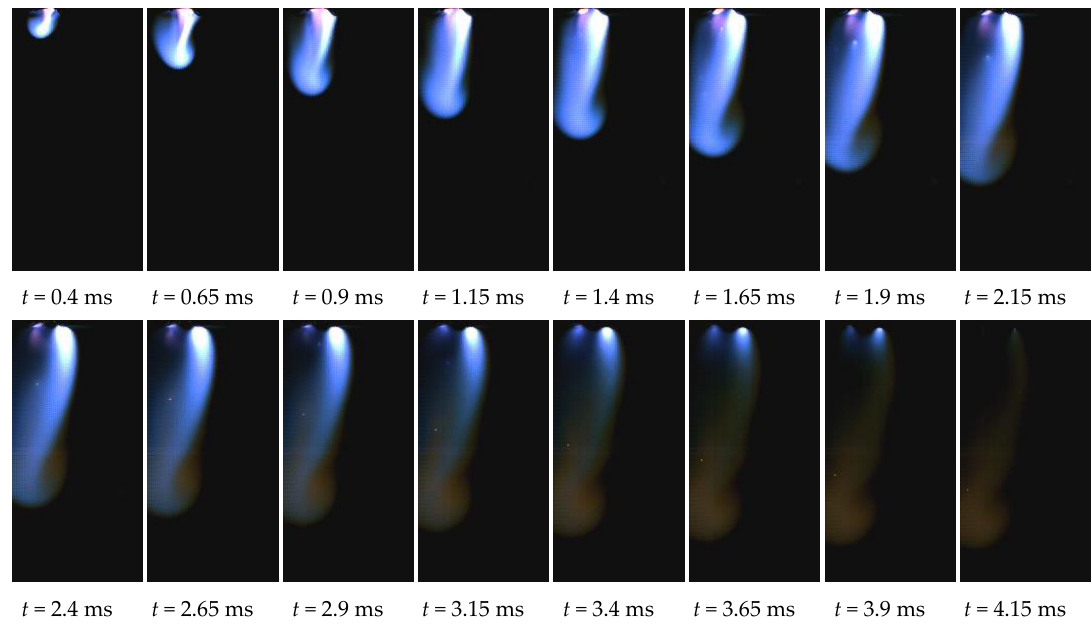
(b) Figure 4. Numerical results of ( a ) Li [54] and ( b ) the present study. 3. Results Analysis and Discussion 3.1. Plasma Jet Flow Characteristics During Discharge